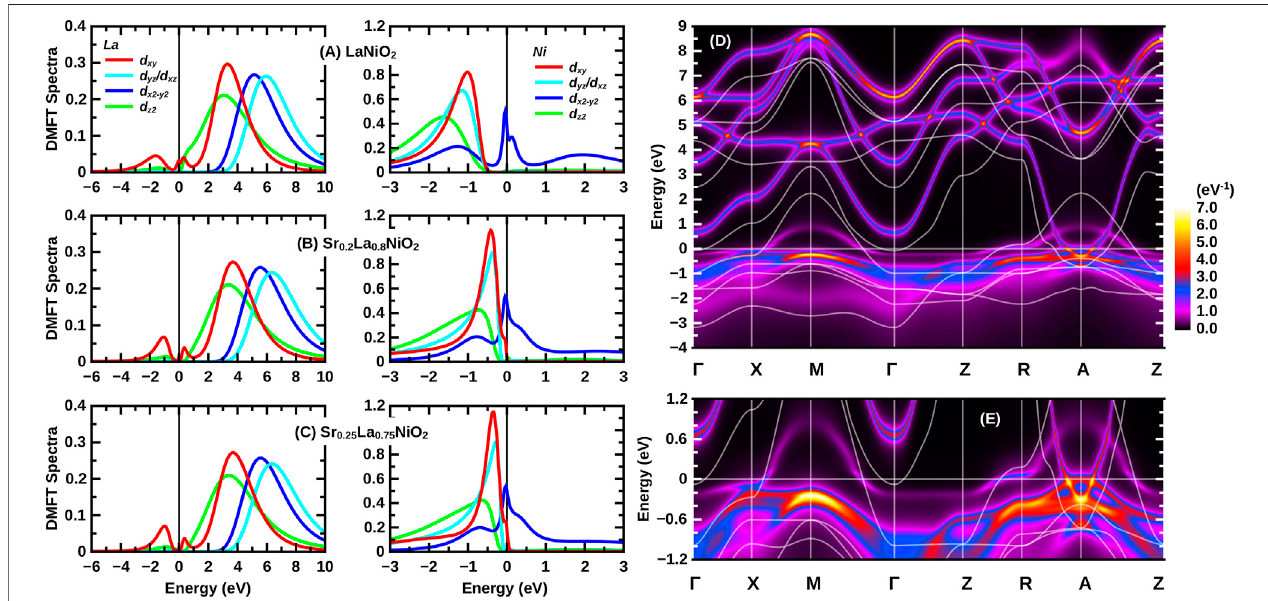
FIGURE3| DMFT k -integrated (A – C) and k -resolved (D,E) spectralfunctions A ( ω )and A ( k , ω )ofundoped LaNiO 2 (A) ,20%Sr-dopedLaNiO 2 (Sr 0.2 La 0.8 NiO 2 ) (B) ,